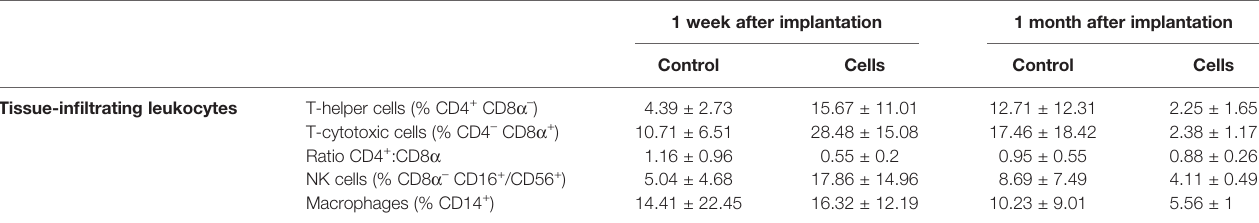
TABLE 5 | Results of the phenotypic analysis by fl ow cytometry of the in fi ltrated leukocytes inside the surgical meshes 1 week and 1 month after mesh implantation. 1 week after